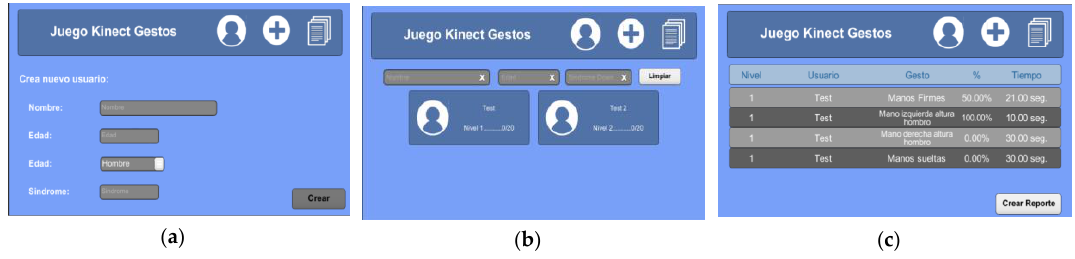
Figure 3. ( a ) User registration; ( b ) list of registered users; ( c ) list of tasks performed.